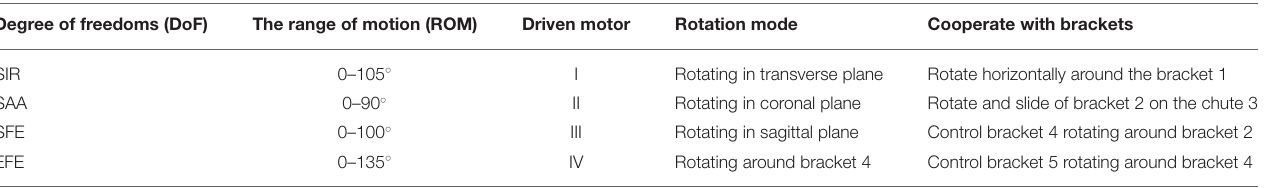
TABLE 1 | Description of motors used in model.